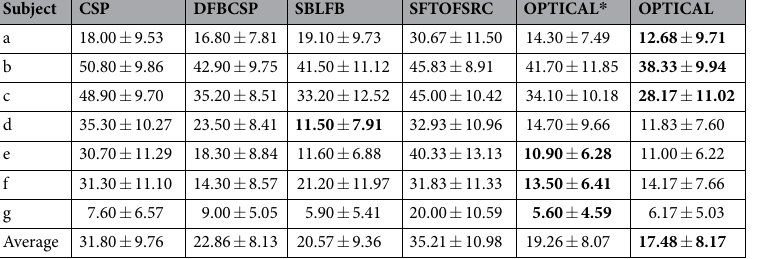
(OPTICAL * : 3 out of 7 subjects for BCI competition IV dataset 1 (our proposed predictor without optimizing LSTM network hyper-parameters) and SBLFB: 11 out of 52 subjects for GigaDB dataset). All methods were able